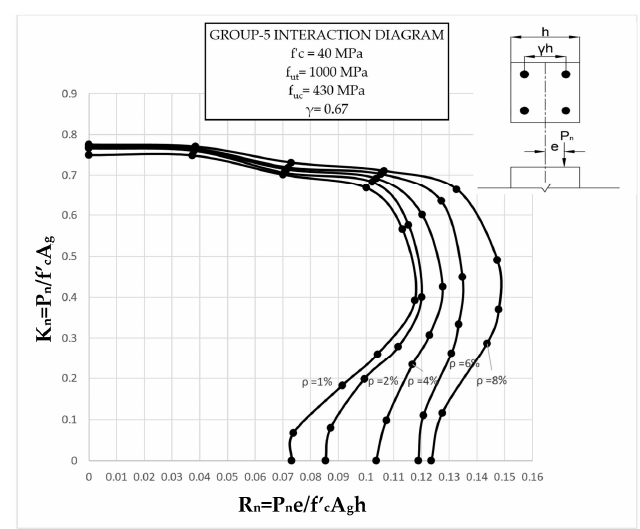
Figure 16. Group 4 interaction diagram.